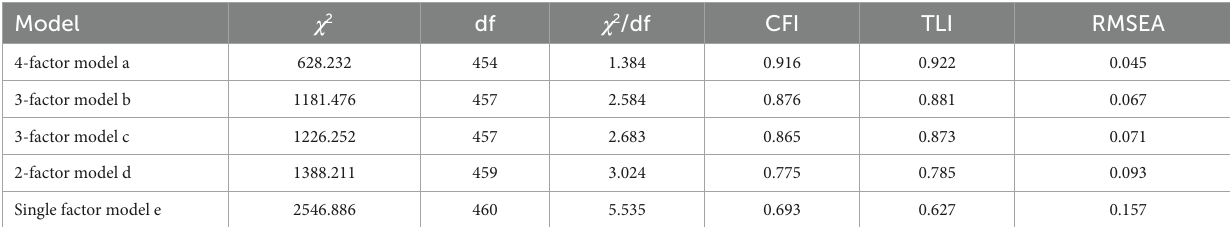
TABLE 3 Confirmatory factor analysis result.